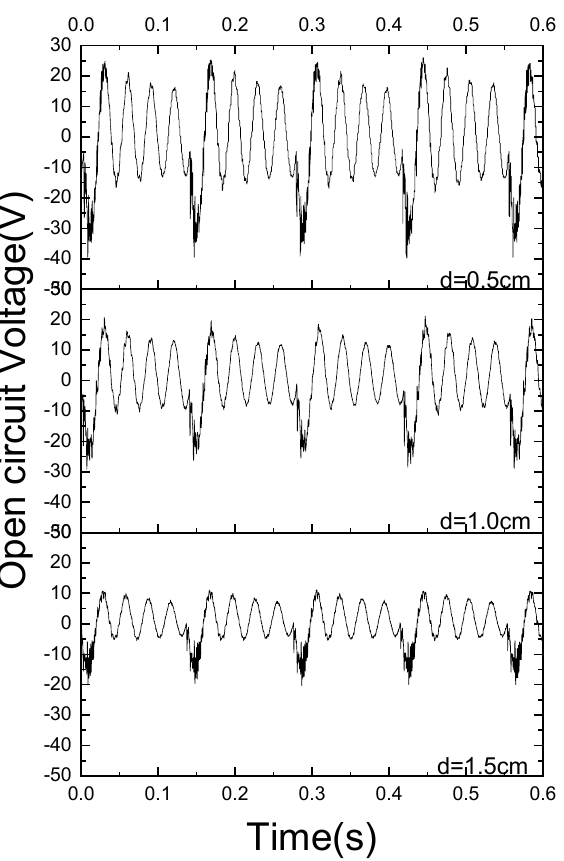
Figure 10. The instantaneous open-circuit voltage of the tuning fork energy harvester with different impact spacing under an acceleration of 0.7 g.